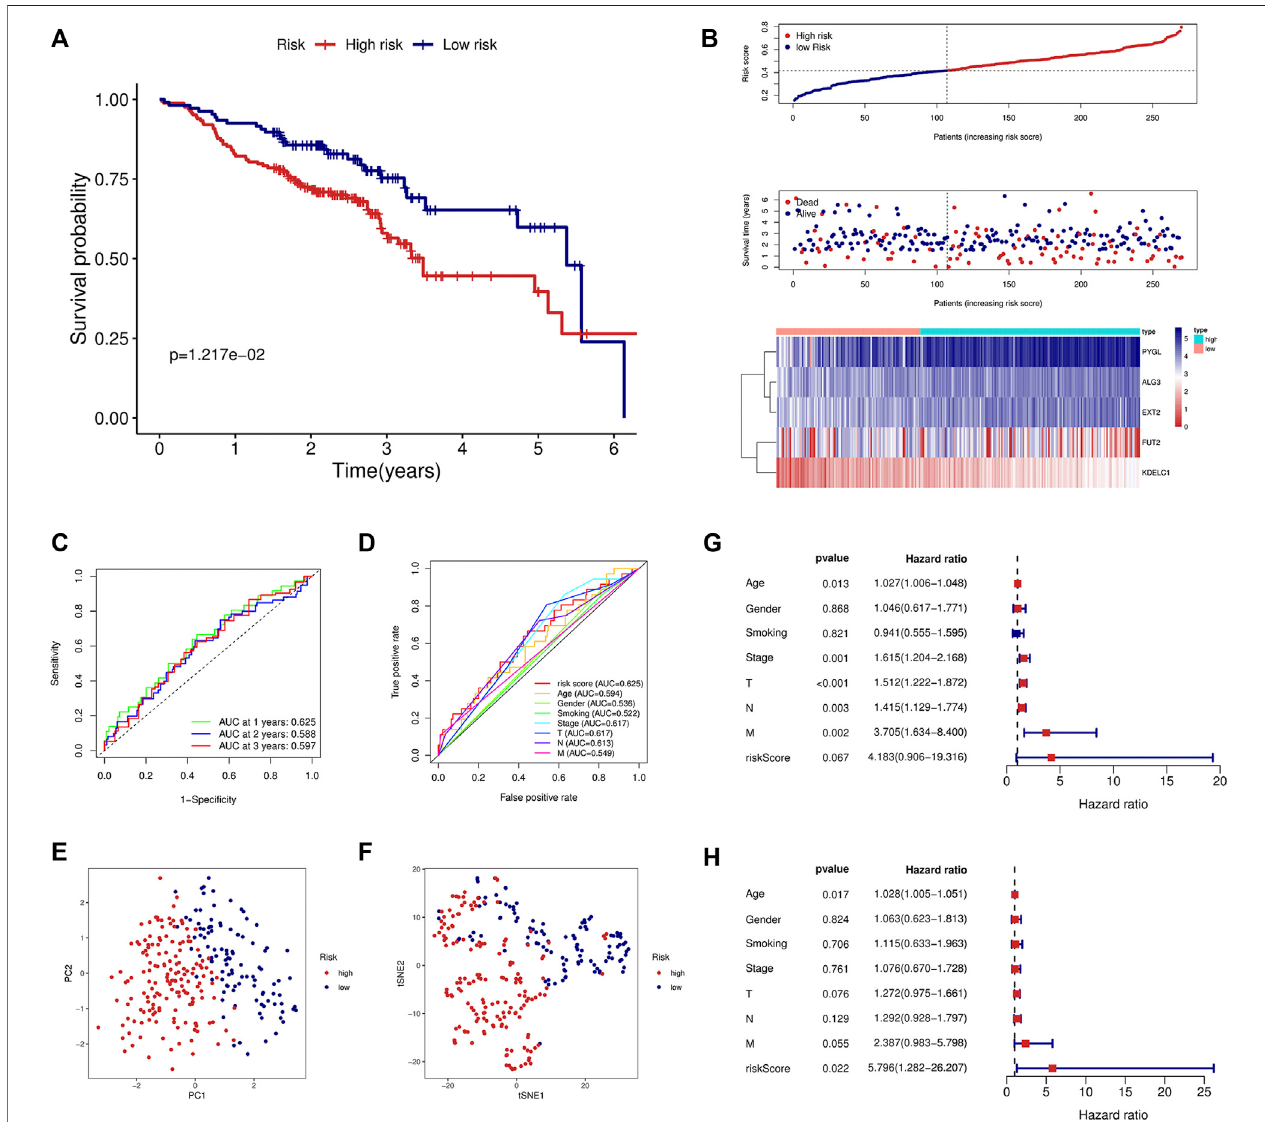
FIGURE3| ValidationoftheprognosticsignatureintheGSE65858validationcohort. (A) KMcurveshowedthatthehigh-riskgrouphadashortersurvivaltimethan the low-risk group. (B) Distribution of the risk score, survival time, and survival status as well as the heatmap between the two groups in the validation cohort. (C) ROC analysisofthesignatureat1-year,2-year,and3-yearsurvivalinthevalidation cohort. (D) ROCanalysisofthesignatureandtheotherclinicalparametersinthevalidation cohort. (E) PCA intheexternal validation cohort. (F) tSNE analysisintheexternal validationcohort. Univariate (G) and multivariate (H) Coxanalyses ofthesignature and the clinical parameters in the validation